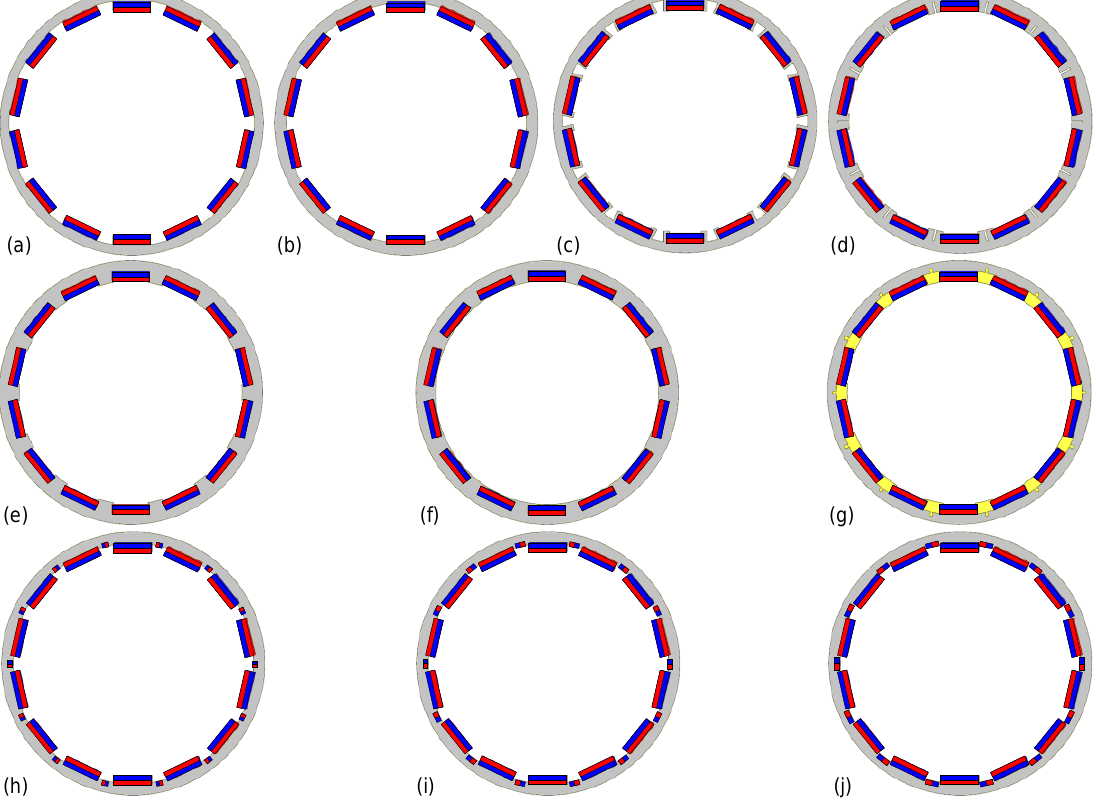
Figure 8. The method of attaching flat magnets to the ERPMSM rotor: ( a ) flat on the rotor surface; ( b ) in milled recesses; ( c ) by hooks with large spacing; ( d ) by hooks with small spacing; ( e ) by hooks with no spacing; ( f ) in cavities buried beneath the rotor surface; ( g ) flat on the rotor surface using paramagnetic holders; ( h ) in milled recesses with reinforcement by Halbach array (short magnets); ( i ) in milled recesses with reinforcement by Halbach array (medium length magnets); and ( j ) in milled recesses with reinforcement by Halbach array (long magnets).